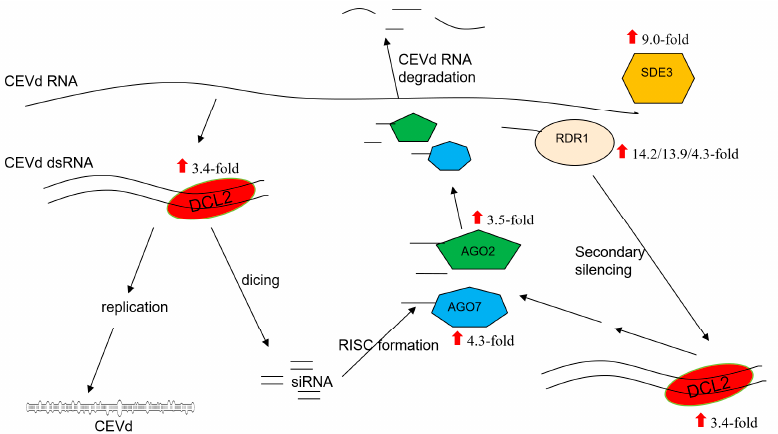
Figure 4. Schematic depiction of the antiviral RNA silencing pathway with differentially expressed genes and their mRNA fold change based on RNA-sequencing (RNA-seq) analysis are shown. DCL2, DICER-LIKE 2; AGO2, ARGONAUTE 2; AGO7, ARGONAUTE 7; RDR1, RNA-DEPENDENT RNA POLYMERASE 1; SDE3, SILENCING DEFECTIVE 3; RISC, RNA-induced silencing complex.